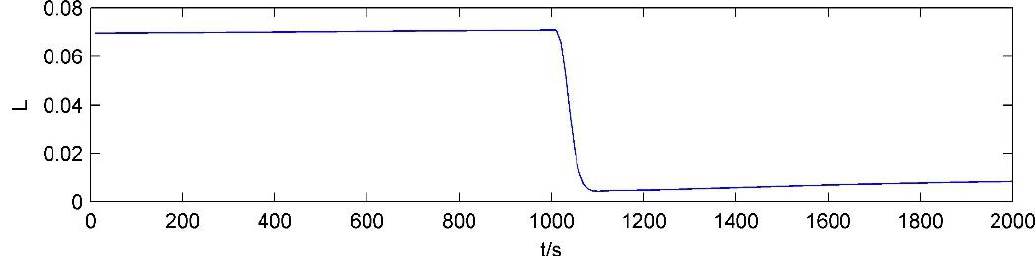
Figure 21. The distribution uniformity of the cluster (switch from disk formation to circle formation).